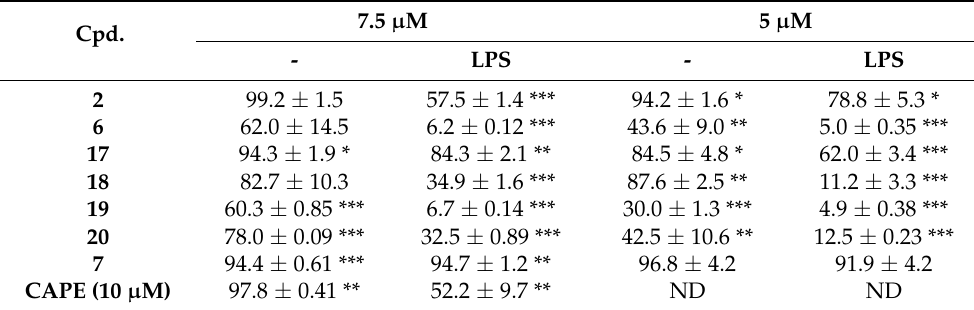
Table 5. Effects of compounds on cell viability of LPS-activated dTHP − 1 cells.